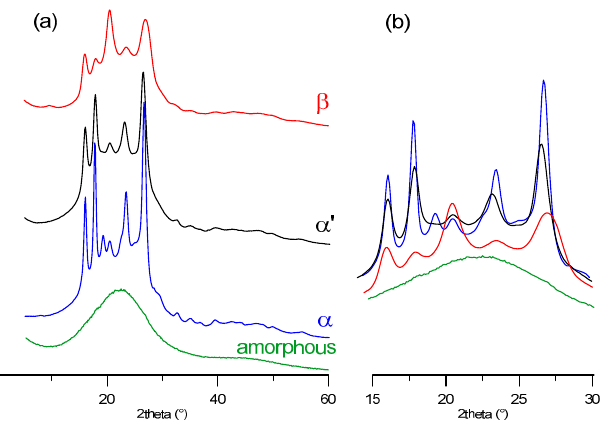
Figure 1. X-ray diffraction (XRD) patterns of PEF: ( a ) from top to bottom: β -, α ’-, α -phase and amorphous sample; ( b ) superposition of the patterns in the range 15°–30°.